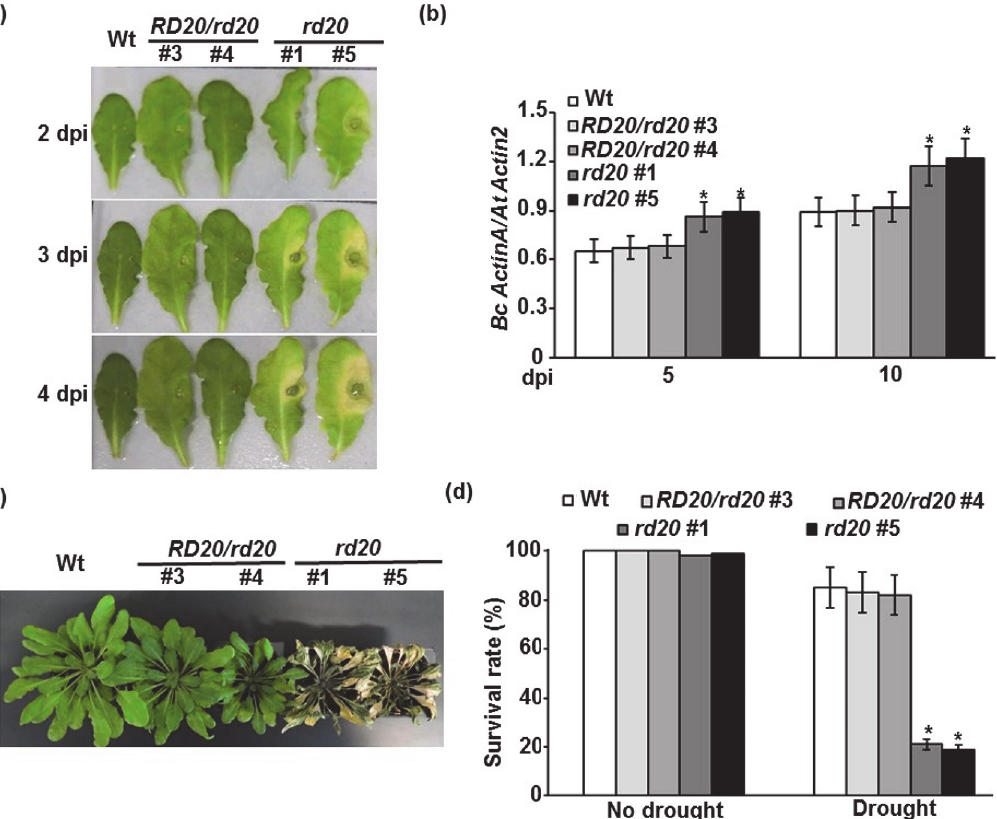
Fig 4. Responses of the Arabidopsis rd20 mutant to B . cinerea infection and drought. Disease symptoms in leaves after drop-inoculation with B . cinerea (A); and fungal growth in plants after spray-inoculation with B . cinerea (B). Drought sensitivity assay on plants 10 days after stopping irrigation (C); and quantitative analysis of survival on plants continued to be not watered for 10 days and then re-irrigated for 3 days (D). In (B), qPCR amplification of Bc ActinA relative to the At Actin2 gene. In (B) and (D), mean values followed by an asterisk are significantly different from the corresponding control ( P < 0.05). All assays were repeated at least three times with similar results. Wt, wild-type; RD20/rd20 , heterozygous line; rd20 , homozygous Bc ActinA , B . cinerea ActinA gene; At Actin2 , Arabidopsis Actin2 gene; dpi, days